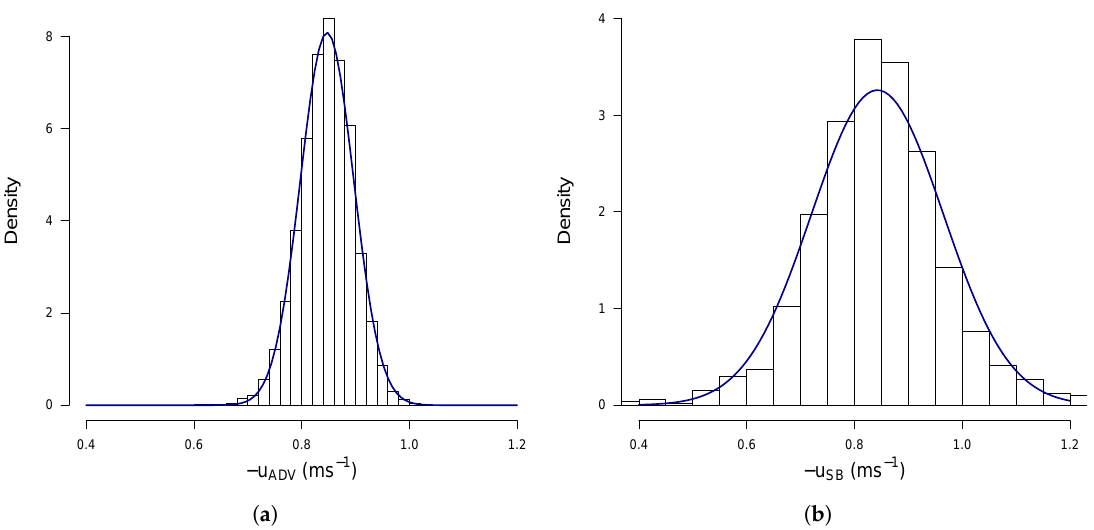
Figure 6. Histograms fitted with normal functions of ( a ) velocity by the ADV from the SuperGen Marine tidal array project [8,29], ( b ) velocity measured by the SB-ADP. This measurements were made at location A.